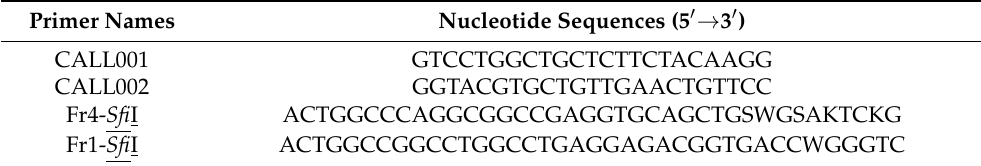
Table 1. Primers’ sequences used to amplify the VHH genes (W = A or T, S = G or C, M = A or C, R = G or